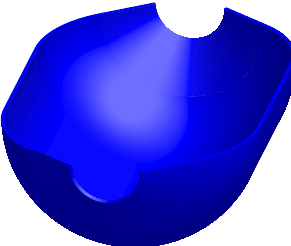
Figure 19 . Folded Strings in EAdS 3 . The spacetime image of the halved worldsheet from figure 7a with a pair of W ± insertions is shown. The inner semicircles correspond to the strong-coupling region ˆ r → −∞ of the linear-dilaton, the θ direction winds around these circles, and the ξ direction extends along the depth of the figure. The left and right boundaries are folded strings extending from the strong-coupling region partway toward finite ˆ r before falling back to strong coupling, while ξ ranges from minus infinity to infinity. The folded strings live on the zero-time slices θ = t R = 0 , θ = it L + π = π of the Lorentzian